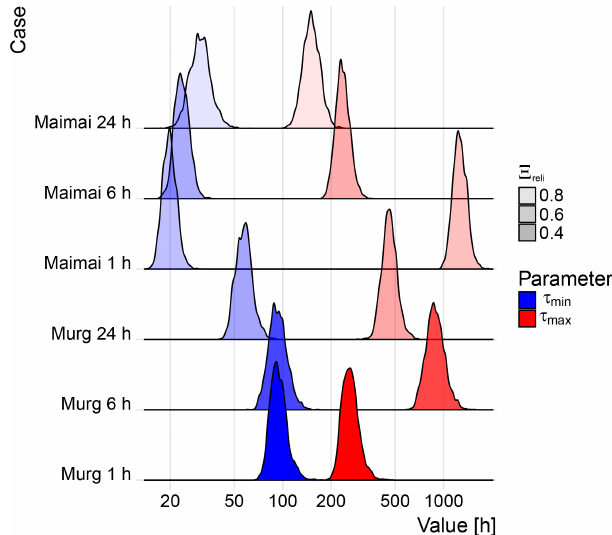
Figure 7. Marginal posterior densities of τ min and τ max , and corre- sponding reliability measures (cid:52) reli in the validation period resulting from error model E3a in all combinations of catchments and tem- poral resolutions.